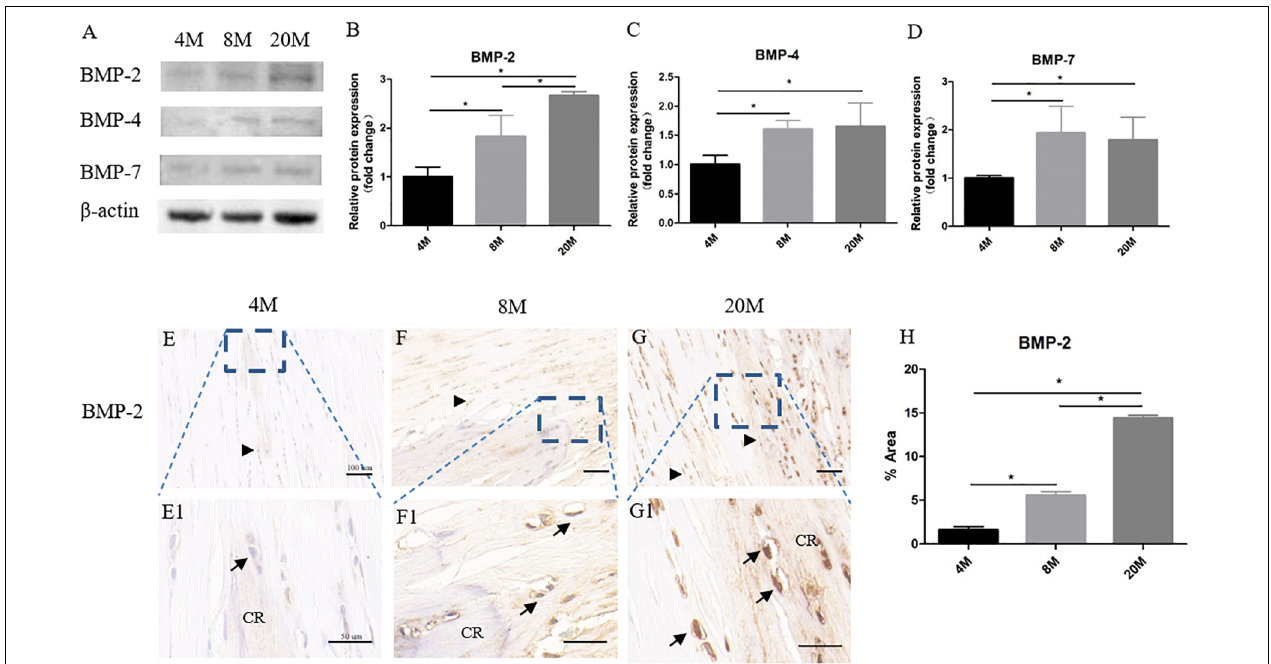
FIGURE 4 | The protein expression of BMP-2/4/7 in ossified tendon was increased with aging. The protein expression of BMP-2/4/7 in ossified tendon aged 4, 8, and 20 M. (A) The protein of BMP-2/4/7 was detected by Western blotting. The semi-quantitative results revealed the protein expression levels of BMP-2 (B) , BMP-4 (C) , and BMP-7 (D) were increased with age. (E–G,E1–G1) IHC staining of BMP-2 in ossified tendon. The semi-quantitative results showed that the expression level of BMP-2 was increased with age (H) . CR, calcified region; arrowhead: rounded tendon cells; arrow: chondrocyte-like cells. Scale bar = 100 µ m (E–G) ; Scale bar = 50 µ m (E1–G1) . ∗ P <